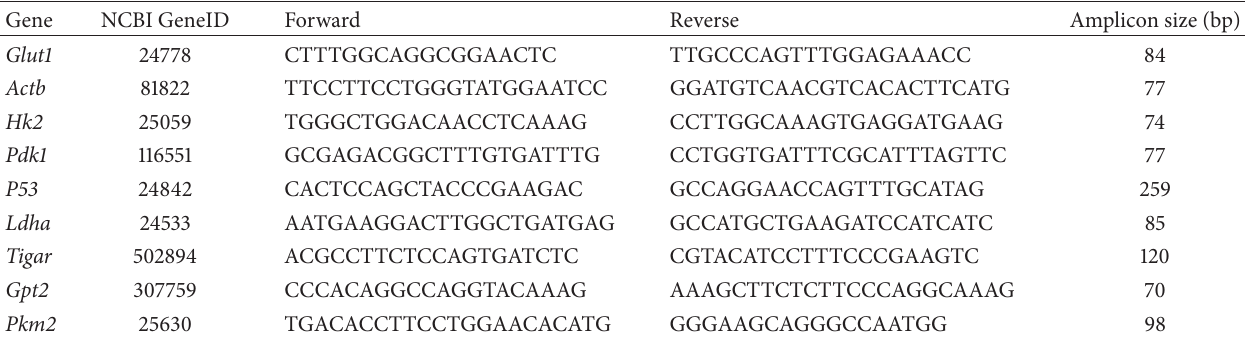
Table 1: List of RT-PCR